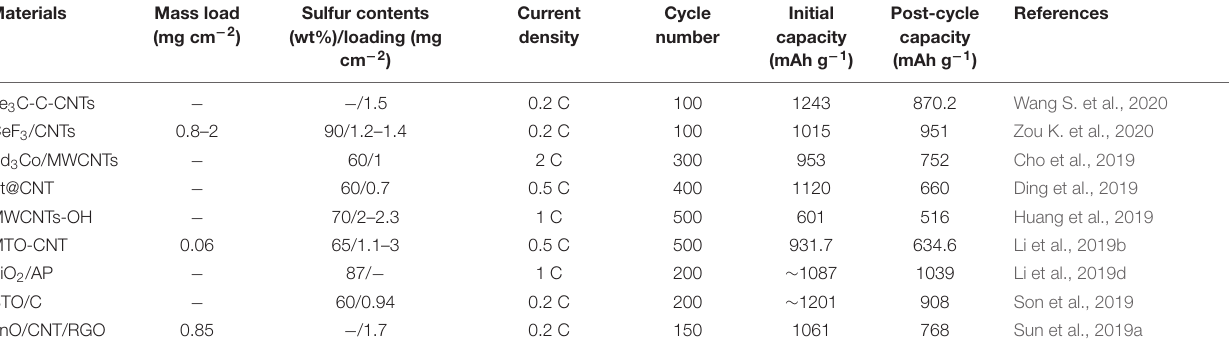
( Figure 1E ). With Sb 2 S 3 /MWCNTs modified separator, the Li– per cycle after cycling 1000 cycles at 1 C), indicated that